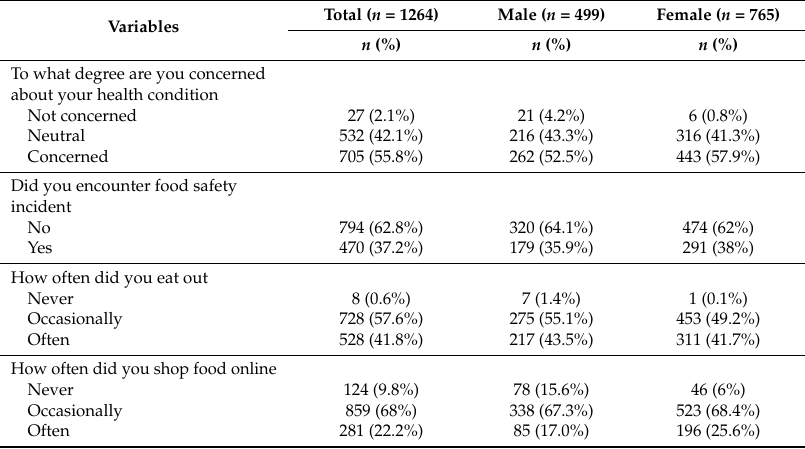
Table 2. Personal involvement of the study population by gender ( n =